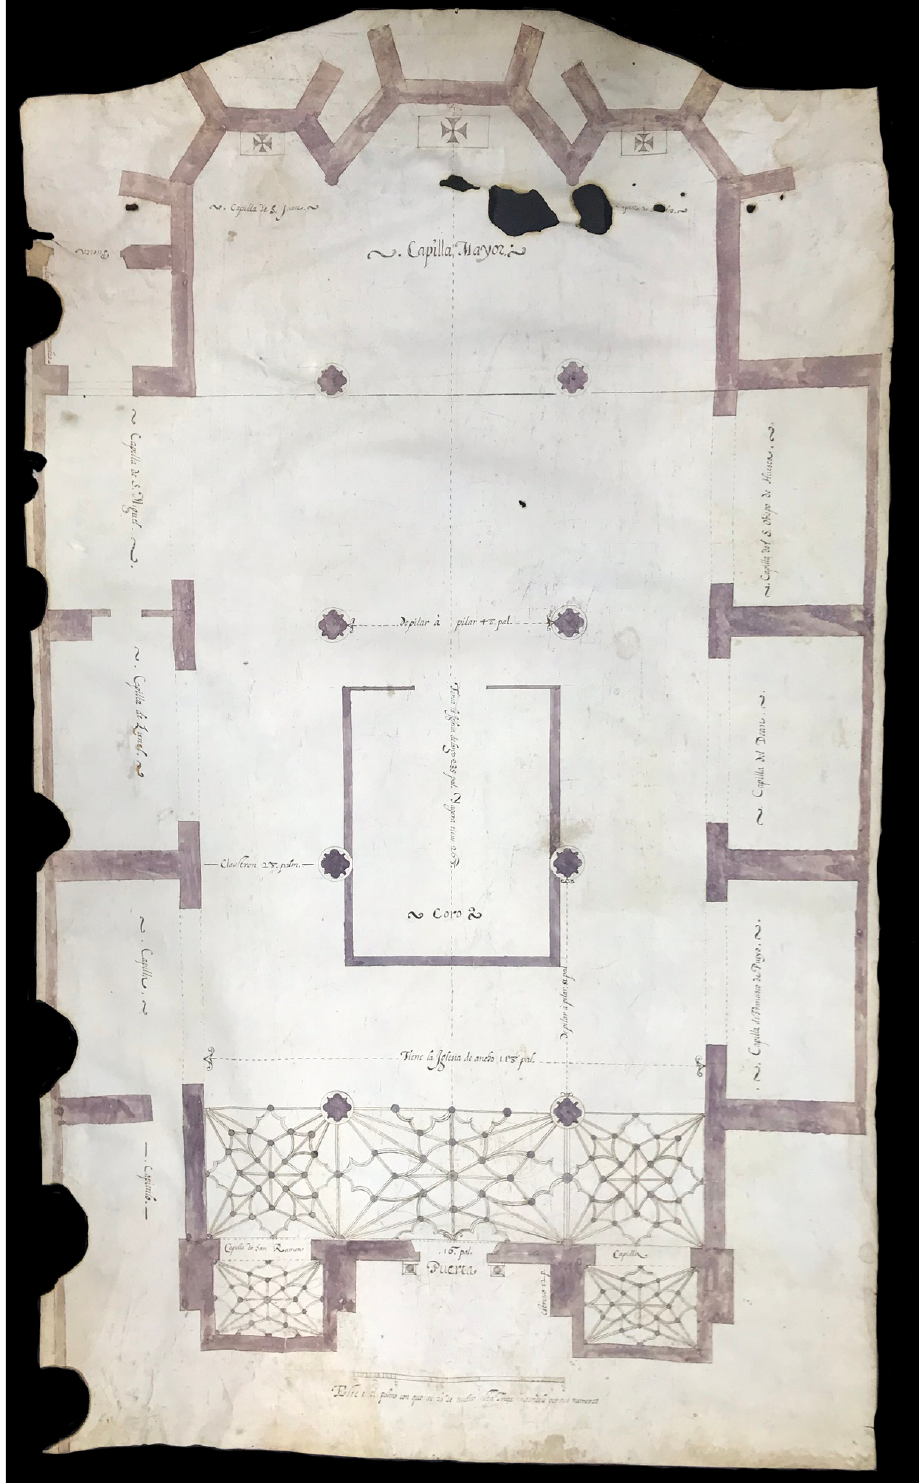
Figure 15. Project for the enlargement of the west end of Barbastro cathedral (Huesca) [Archivo Diocesano de Barbastro (A.D.B.)]. © Archivo Diocesano de Barbastro.